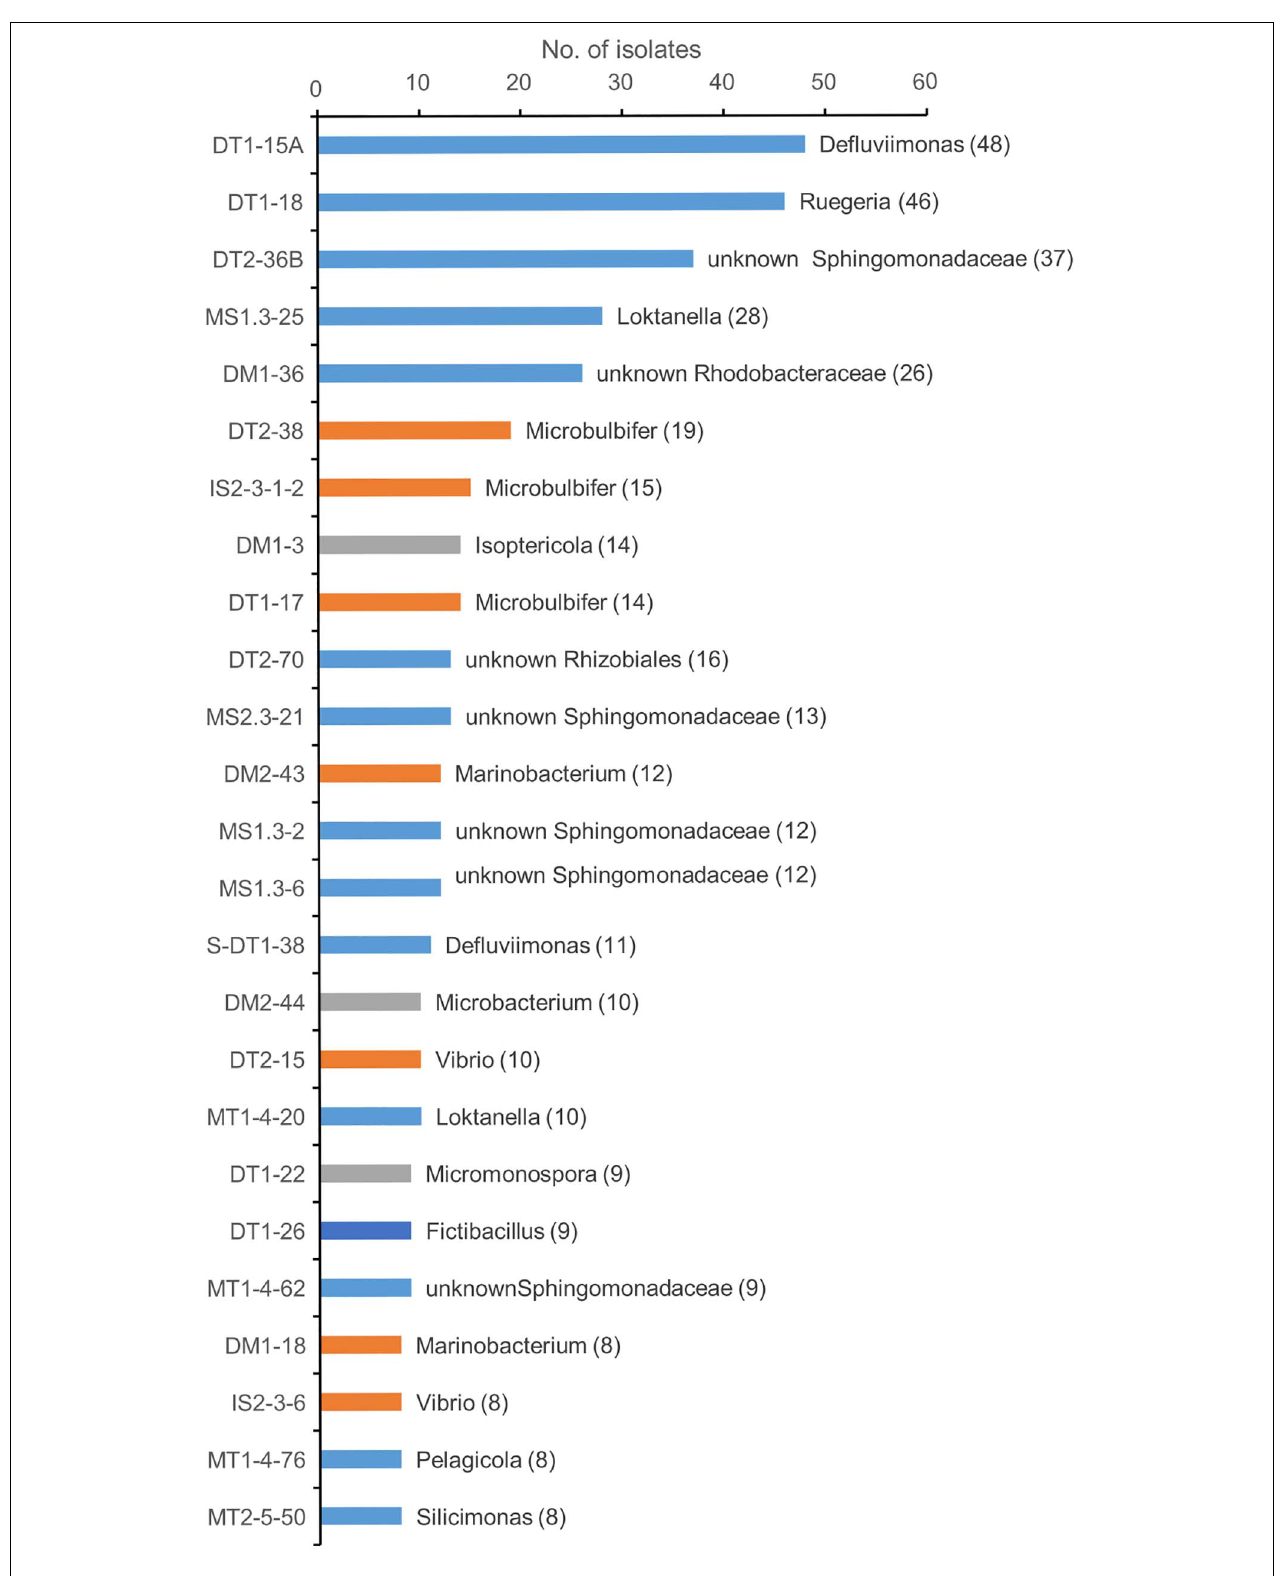
FIGURE 2 | Taxonomic diversity of predominant genotypes at genus level. Different color represents the classification of the representative genotype at class ranks: blue, orange, gray, and dark blue for Alphaprotebacteria, Gammaproteobacteria, Actinobacteria, and Bacilli, respectively. The genotypes were classified using SILVA database. The representative isolate was shown. The numbers in the parentheses showed the number of genotypes.